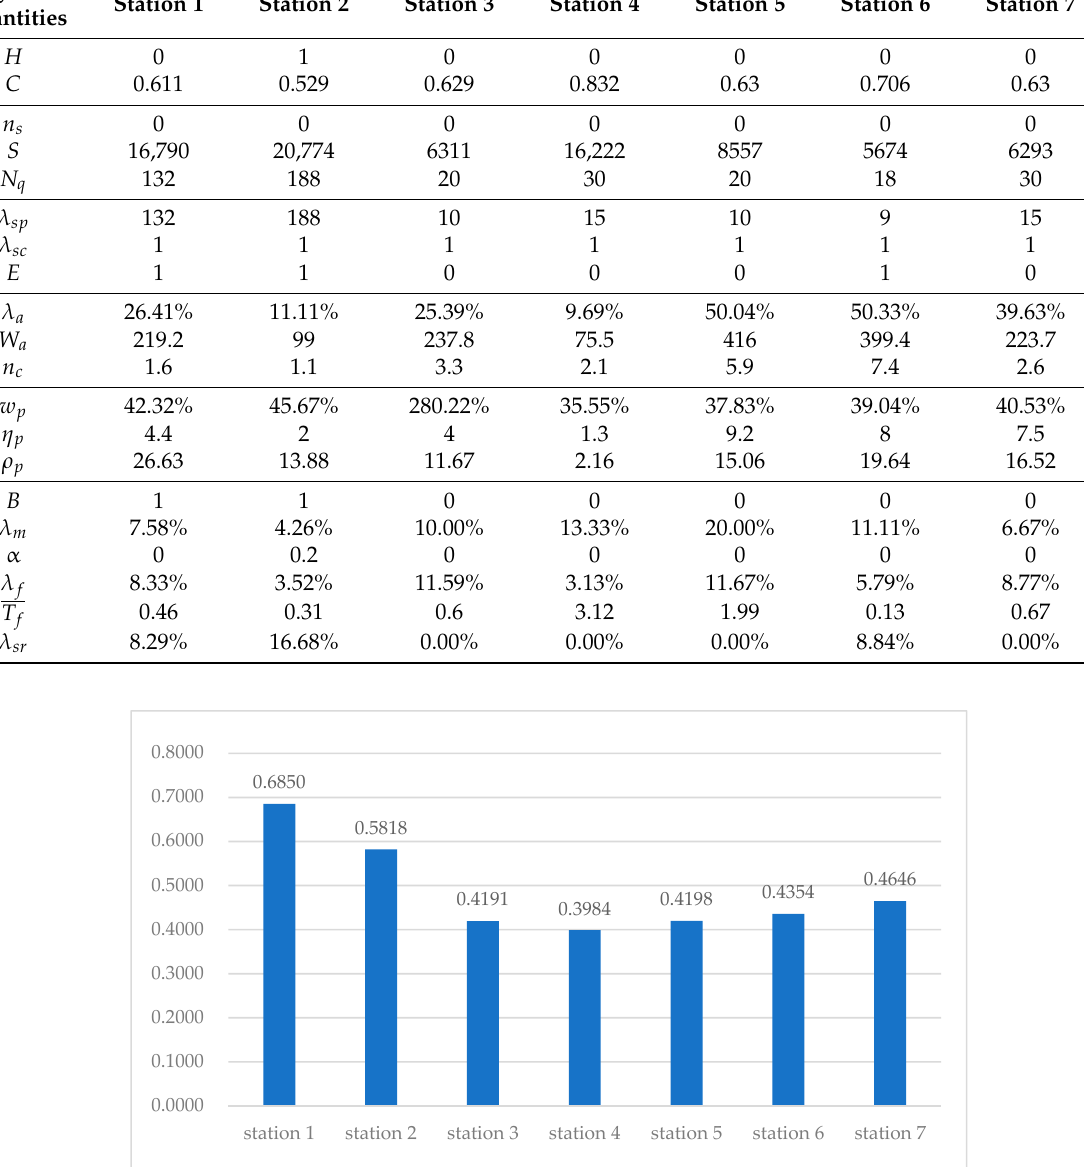
Table 7. The physical quantities of the evaluation indicators of seven charging stations.